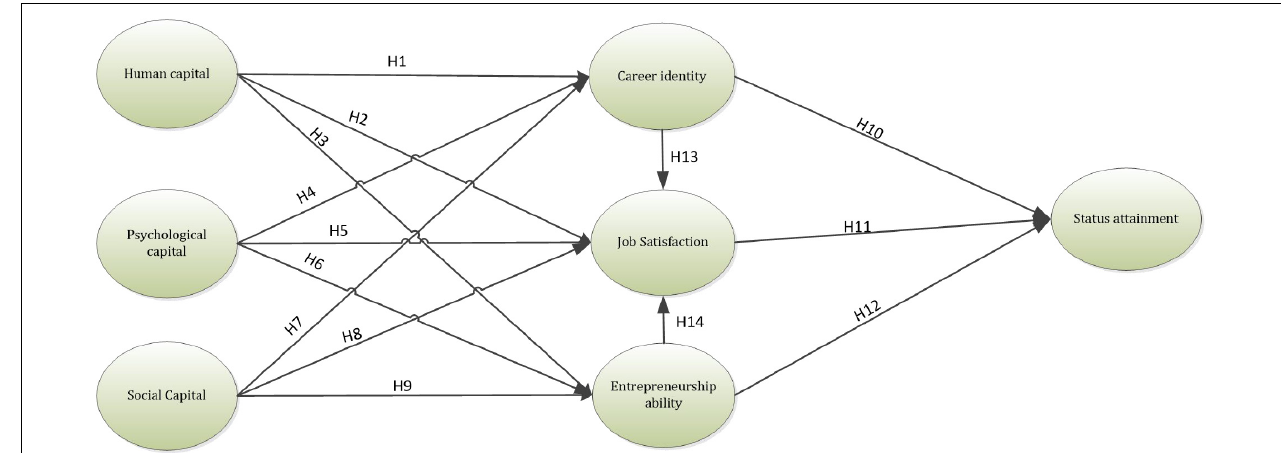
FIGURE 1 | Theoretical